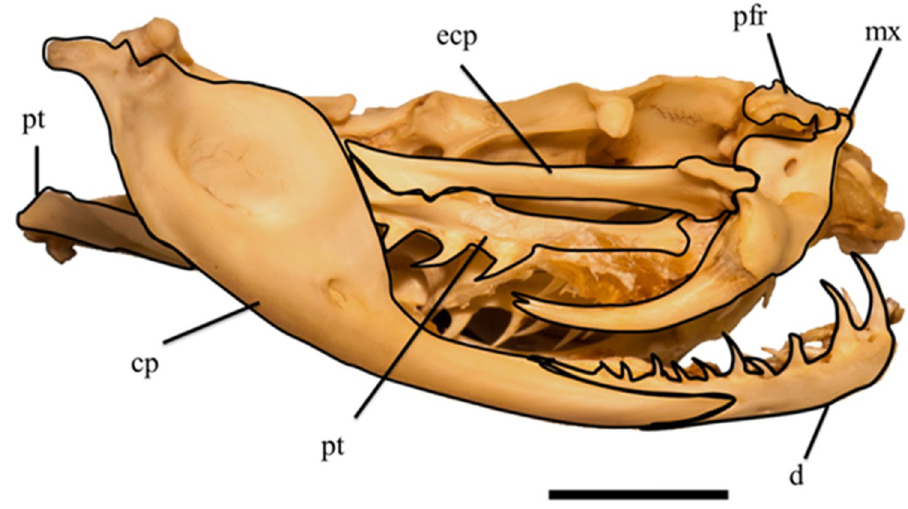
Fig 2. Skull of Tropidolaemus wagleri (APPSU 25797) in right lateral view. Anterior is to the right. Scale bar = 10 mm. Abbreviations: ecp = ectopterygoid; cp = compound bone; d = dentary; mx = maxilla; pfr = prefrontal; pt = pterygoid.